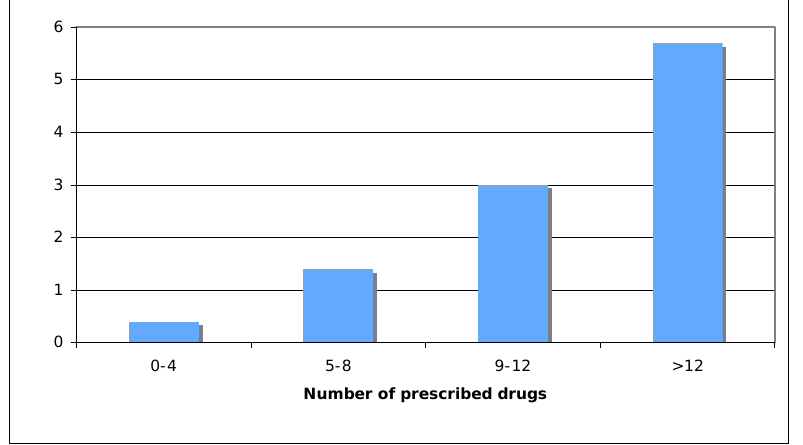
Figure 1 Correlation of number of prescribed drugs and number of drug-drug